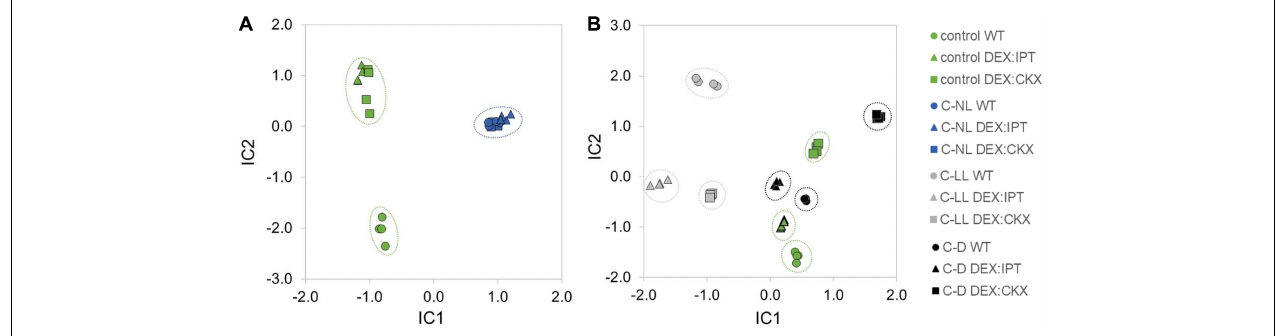
FIGURE 7 | The independent component analysis (ICA) of proteome profiles in leaves of WT, DEX:IPT , and DEX:CKX plants. (A) Cold stress response at standard light intensity (C-NL) masks the effect of altered cytokinin pool. Results represent the quantitative analysis of 2,067 proteins in four replicates. (B) The response to cold stress under low light (C-LL) and dark (C-D) conditions in comparison with plants grown under control conditions. The ICA separates light intensity and cytokinin effects in the IC1 and IC2 axes, respectively. The results represent the quantitative analysis of 1,950 proteins in four replicates.